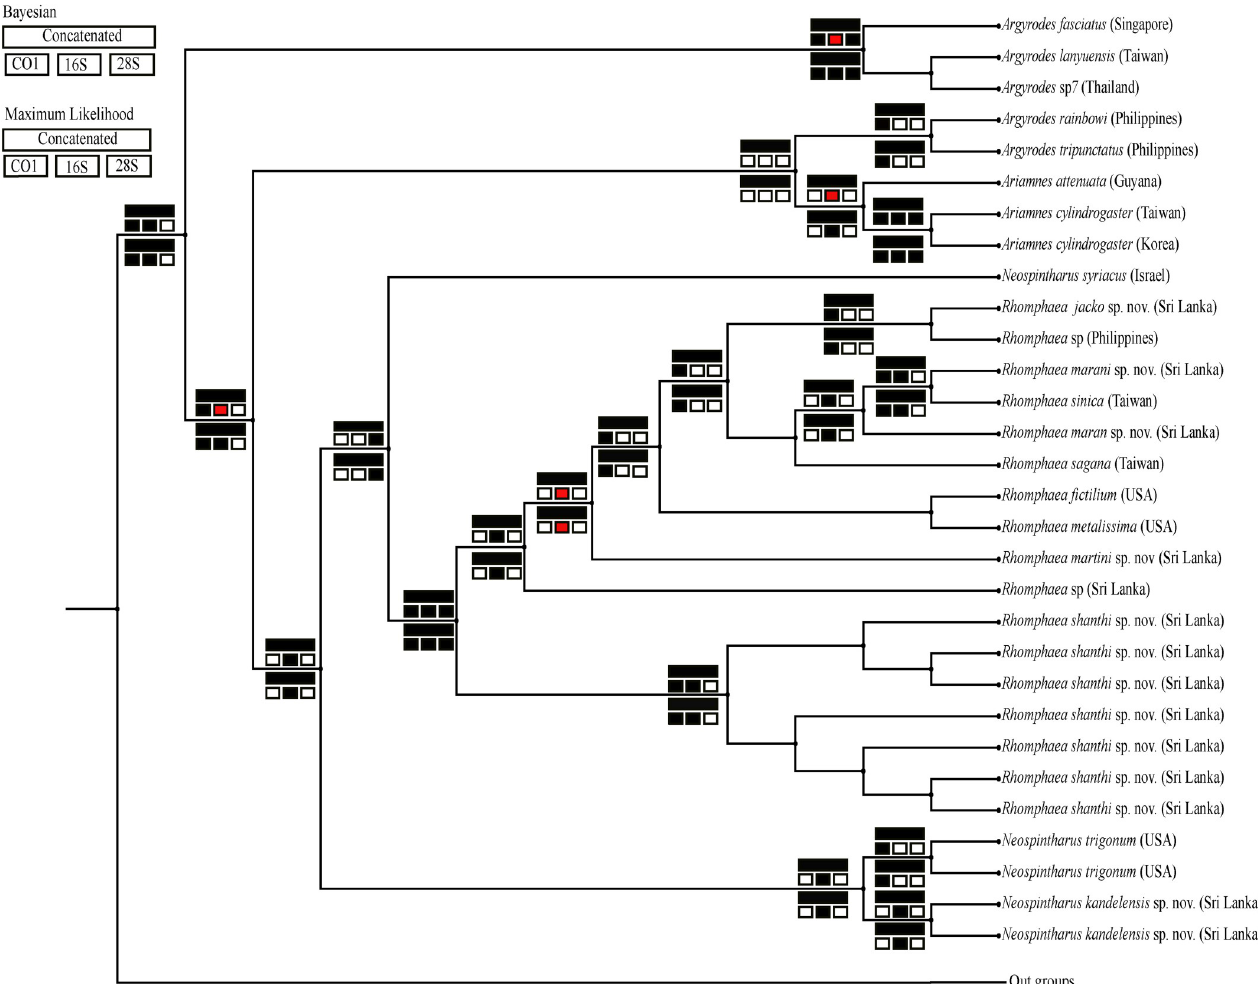
Fig 2. Summary phylogenetic tree of the Bayesian and Maximum Likelihood analyses of the three individual genes as well as the concatenated molecular data. The tree recovered from the ML analysis of the concatenated molecular data is used here as it is better resolved. Key: “Navajo rugs” indicate posterior probability support of a node is larger than 0.7 in Bayesian analysis and larger than 70 in ML analysis of the individual gene or in concatenated data (black), or nodal supports values between 0.6–0.7 in Bayesian and 60–70 in ML analysis (red), absence of a given node in the tree specified in the legend